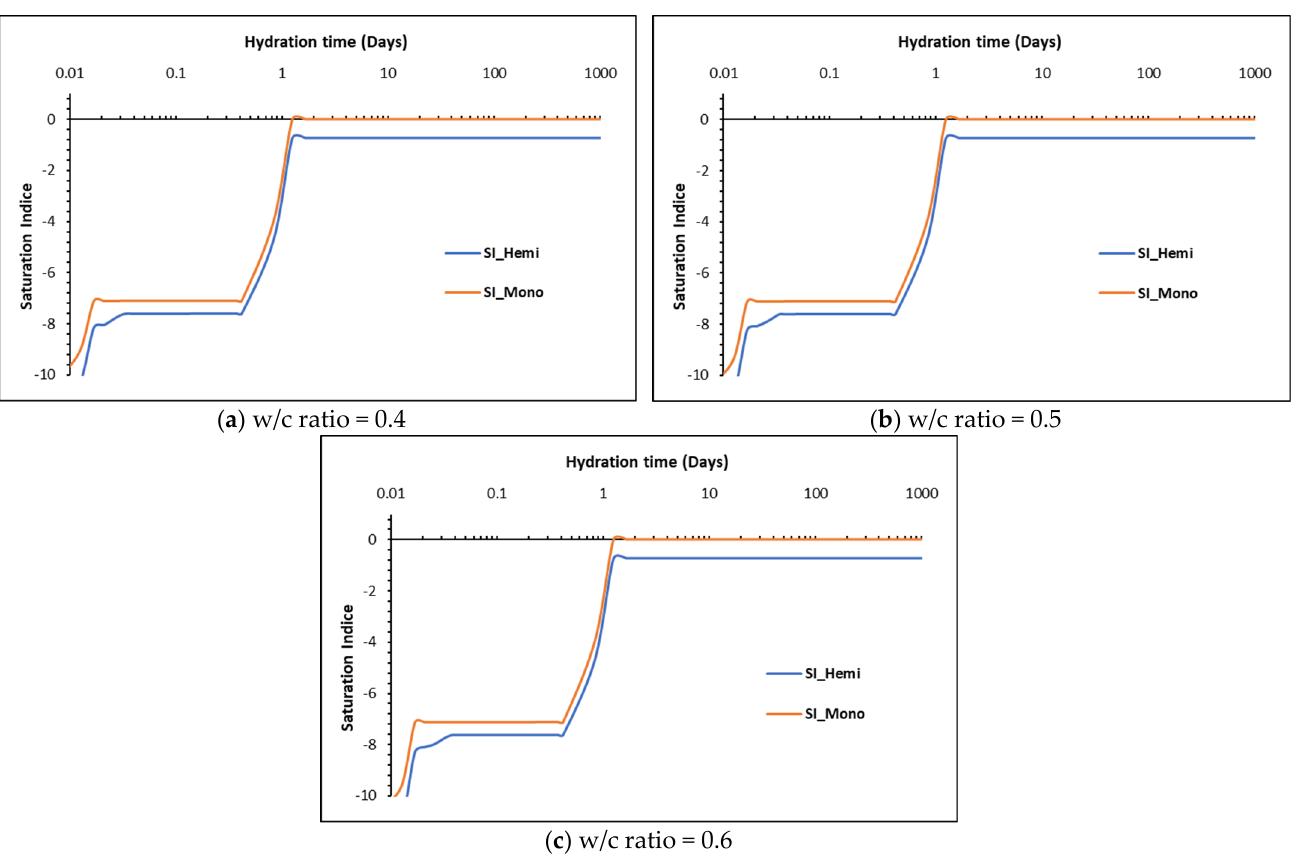
Figure 9. Calculated saturation indices for hemicarbonate and monocarbonate for the three w/c ra- tios.